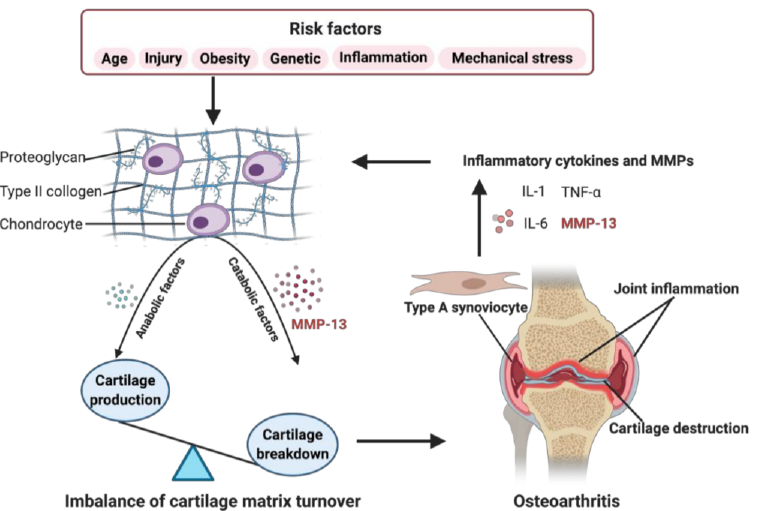
Figure 1. Role of matrix metalloproteinase-13 (MMP-13) in osteoarthritis (OA) pathogenesis. When some OA risk factors lead to increased expression of chondrocytes’ catabolic factors, like MMP-13, the balance tips toward a net loss of cartilage. MMP-13 is the primary catabolic factor involved in cartilage degradation through its particular ability to cleave type II collagen. The breakdown products of cartilage stimulate the type A synoviocytes to release inflammatory cytokines and MMPs, like tumor necrosis factor alpha (TNF- α ), interleukin (IL)-1, IL-6, and MMP-13, which, in turn, enhance a more comparable catabolic effect on chondrocyte metabolism, accelerating the progression of OA. Created with